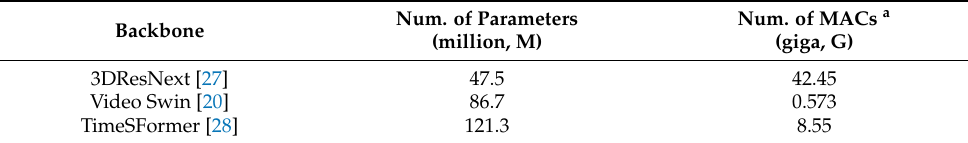
Table 3. Backbone information.